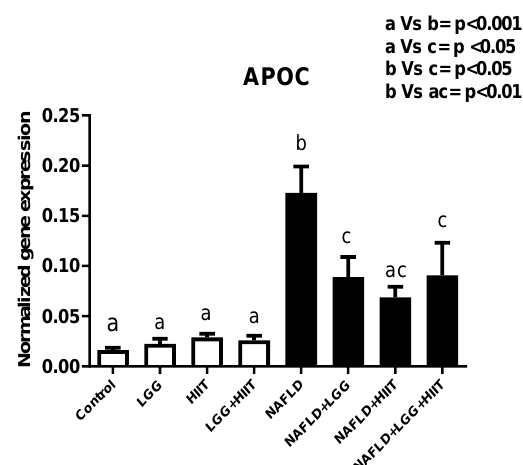
Figure 8: Liver tissue Apolipoprotein C ( APOC ) mRNA expression in different groups of study. All values are the mean ± SD (n = 10 per group). Val- ues with different superscripts are significantly dif- ferent, p < 0.05. LGG: Probiotic L . Rhamnosus